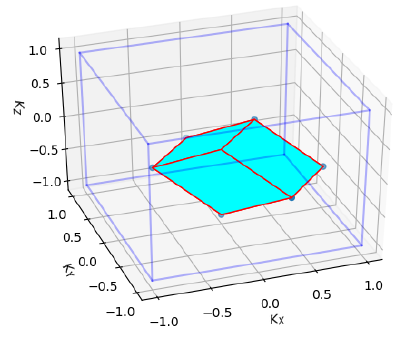
Figure 1. The parallelepiped in the figure represents one of the 16 boxes that tiled the entire first Brillouin zone. The outline of the cube delineates the boundary of the first Brillouin zone. K x , K y and K z are in units of π